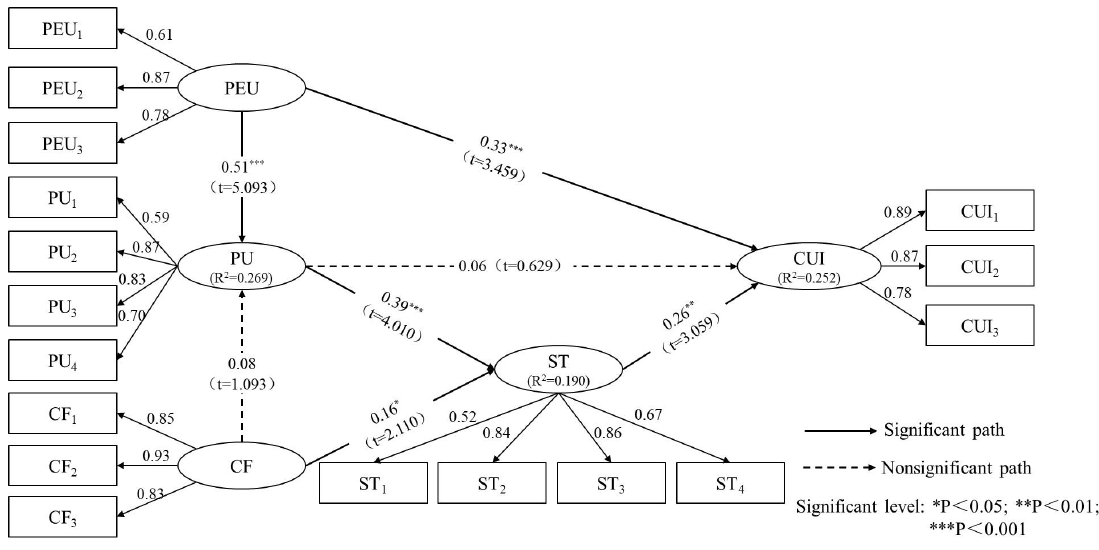
Figure 2. Results of SEM analysis.